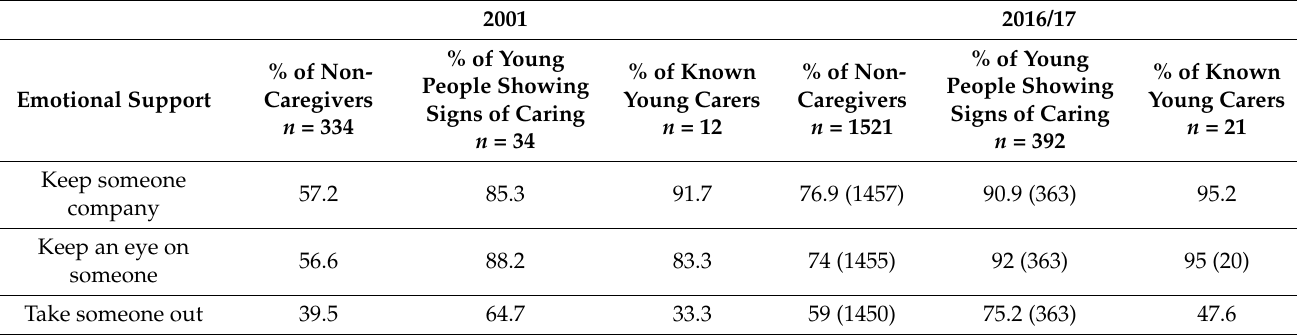
Table 7. Nature of emotional support given by non-young carers, young people showing signs of caring and known young carers in 2001 and 2016/17.